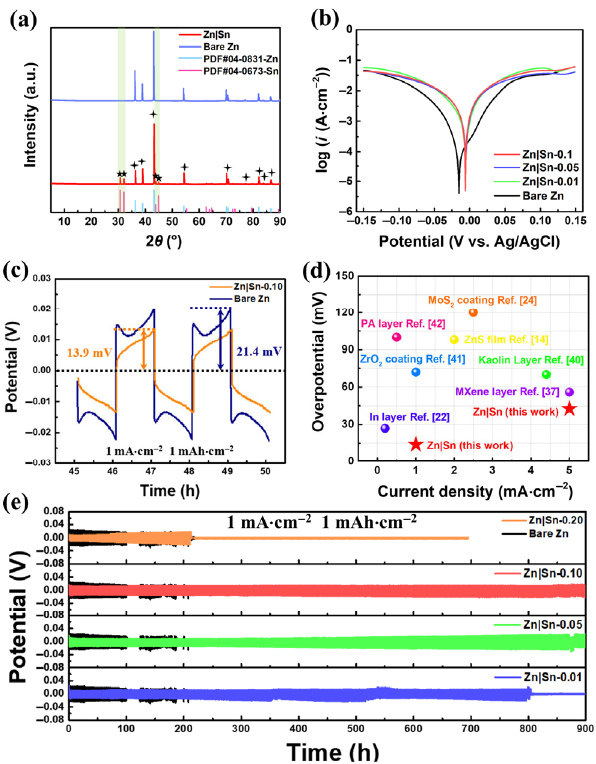
Figure 2 (a) XRD patterns of bare Zn and Zn|Sn. (b) Tafel curves of bare Zn and Zn|Sn- X in 2 M ZnSO 4 electrolyte aqueous solution. (c) Detailed voltage profiles of Zn|Sn-0.10 and bare Zn symmetric cells. (d) Comparison of overpotential between Zn|Sn and Zn anodes reported in the literature. (e) Cycling performance of bare Zn and Zn|Sn- X in symmetric cells at 1 mA·cm −2 for 1 mAh·cm −2